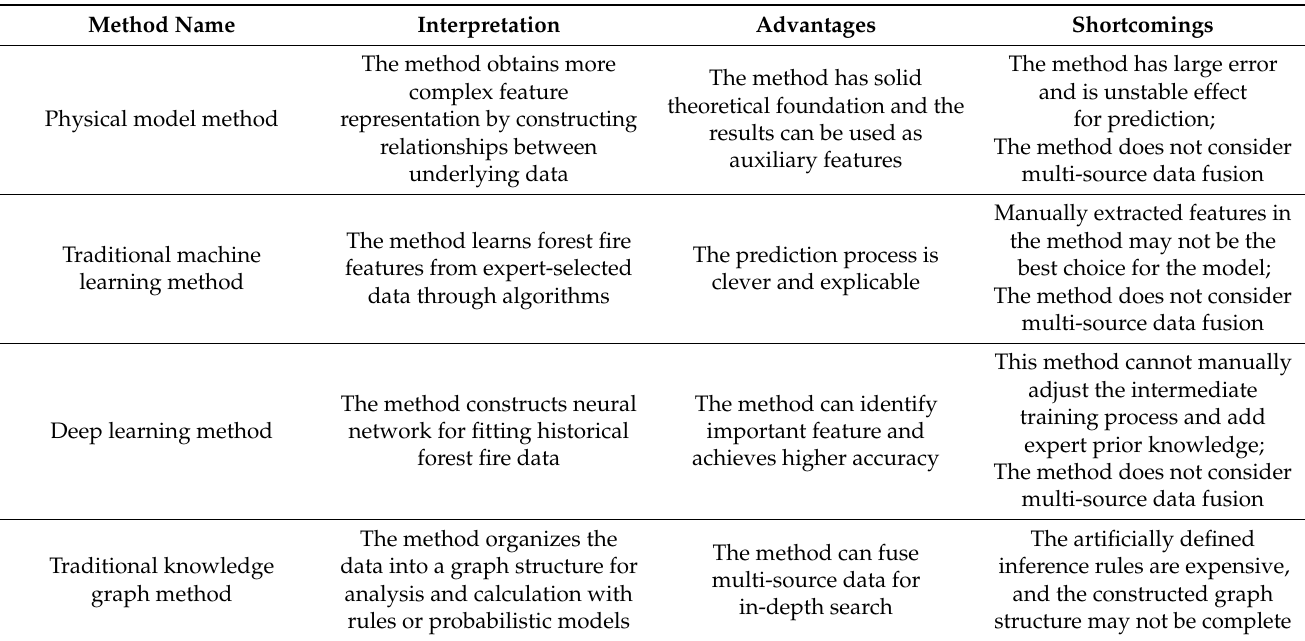
Table 1. Summary of commonly used forest fire prediction